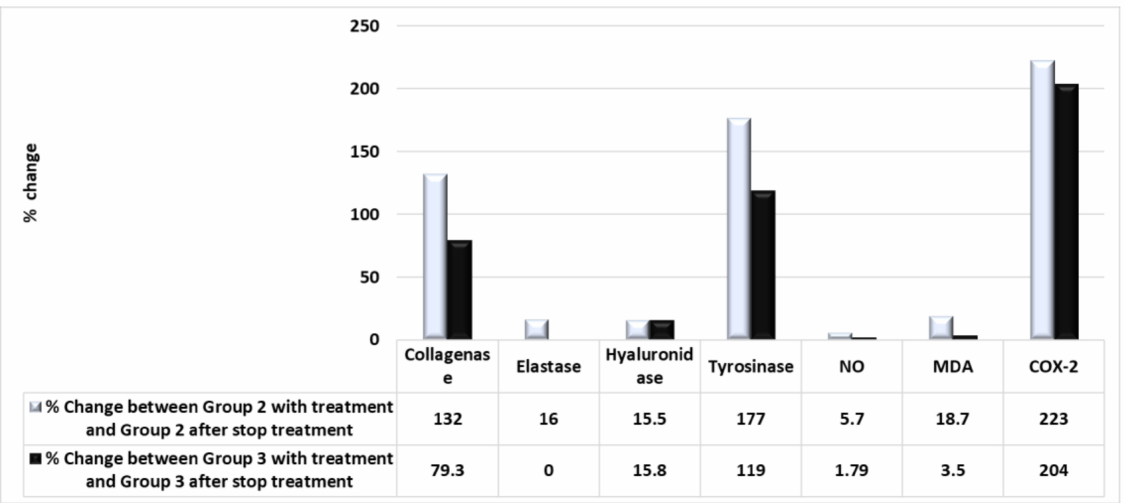
Figure 8. The recurrence of inflammatory activity as a percentage change. Comparison between Group 2 (PSOE treatment group) with treatment for 21 days with Group 2 after stopping treatment with PSOE after 21 days, showing recurrence of inflammatory activity as a percentage change. Comparison between Group 3 (TROSYD treatment) with treatment for 21 days with Group 3 after stopping treatment with TROSYD treatment after 21 days, showing recurrence of inflammatory activity as a percentage